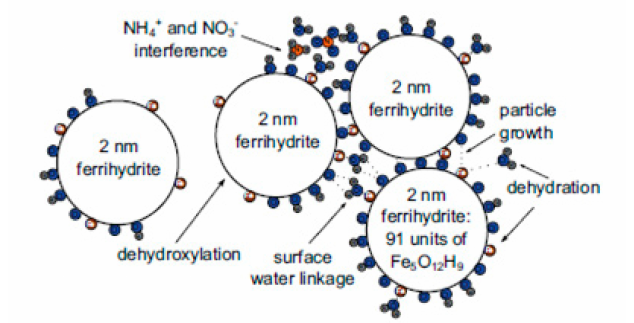
Figure 3. Illustration of agglomerate formation from ferrihydrite precursor particles. Large circles represent cross-sections of 2 nm spheres of ferrihydrite, whereas smaller circles represent 1.5 Å atomic cross-sections. Adapted from Ref.